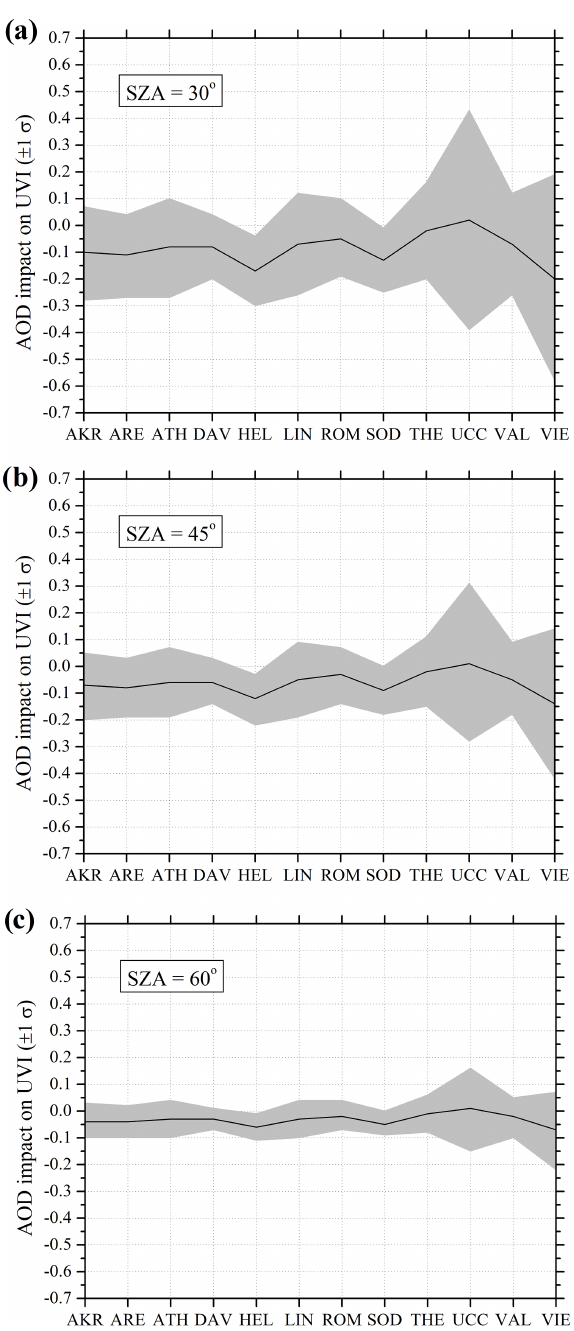
Figure 8. The mean bias error of the CAMS–AERONET AOD im- pact on UVI for all stations with available data as a function of SZA at 30 ◦ (a) , 45 ◦ (b) and 60 ◦ (c) together with the uncertainty range ( ± 1 σ ).